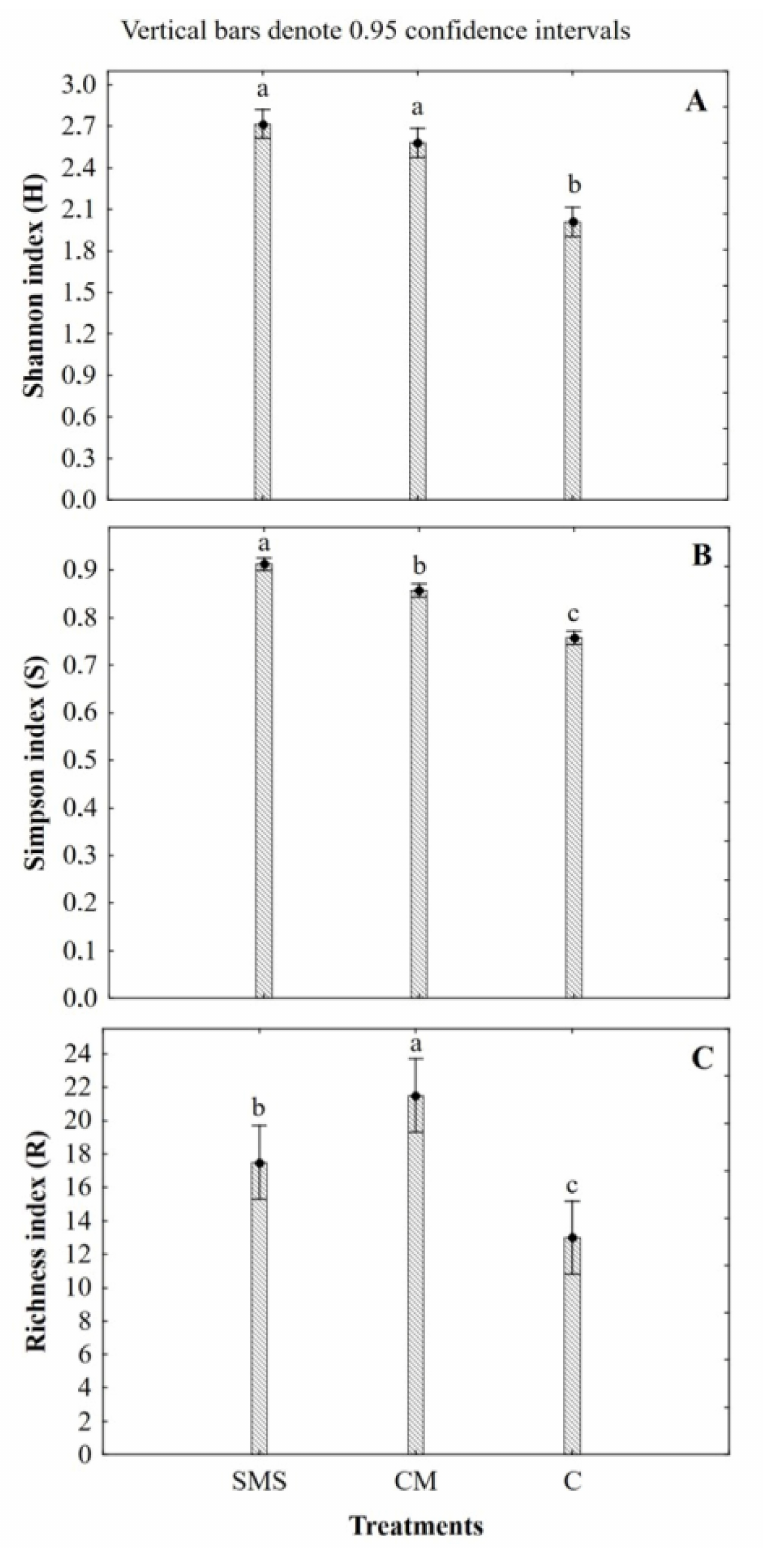
Figure 3. The diversity indices Shannon ( A ), Simpson ( B ) and Richness ( C ) are based on fungal ITS analysis by t-RFLP calculated based on the average of both restriction enzymes. Different letters above columns denote a significant difference ( p < 0.05, Tukey’s test). SMS—spent mushroom substrate, CM—chicken manure, CS—control